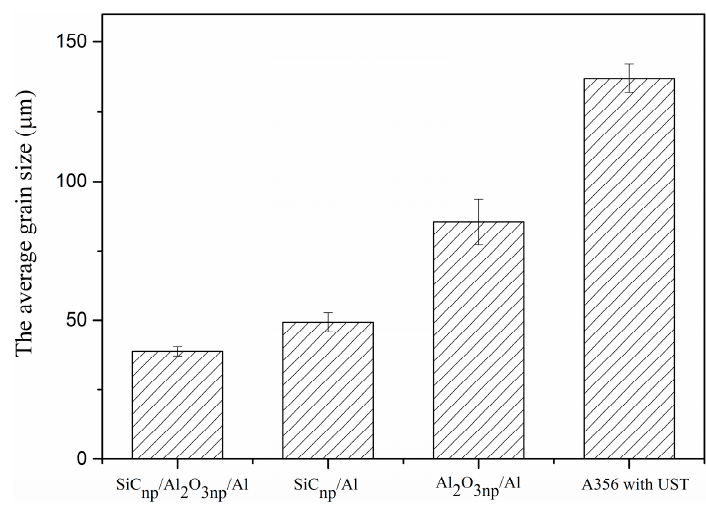
Figure 3. The average grain size of the matrix in nanocomposites and the matrix alloy.